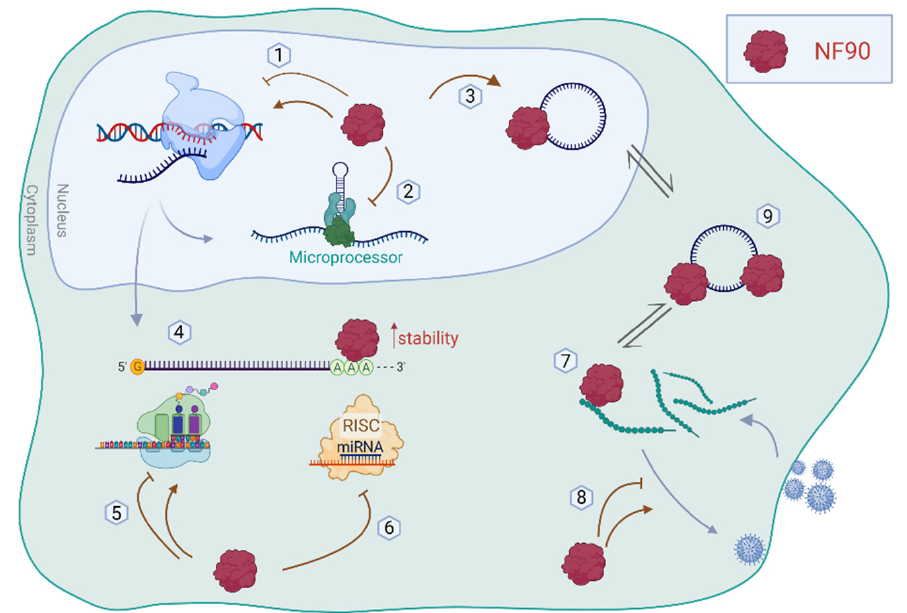
Figure 2. Schematic representation of the functions of NF90 in the cytoplasm and nucleus. NF90 is involved in (1) transcription regulation, (2) miRNA biogenesis, and (3) circRNA biogenesis, in the nucleus. In the cytoplasm, NF90 can regulate (4) mRNA stability, (5) translation of mRNA, and (6) RISC-mediated silencing. In addition, NF90 is implicated in viral infection by (7,8) binding viral genome/proteins. (9) NF90 can be sponged by circRNAs, modulating its availability in the cytoplasm.